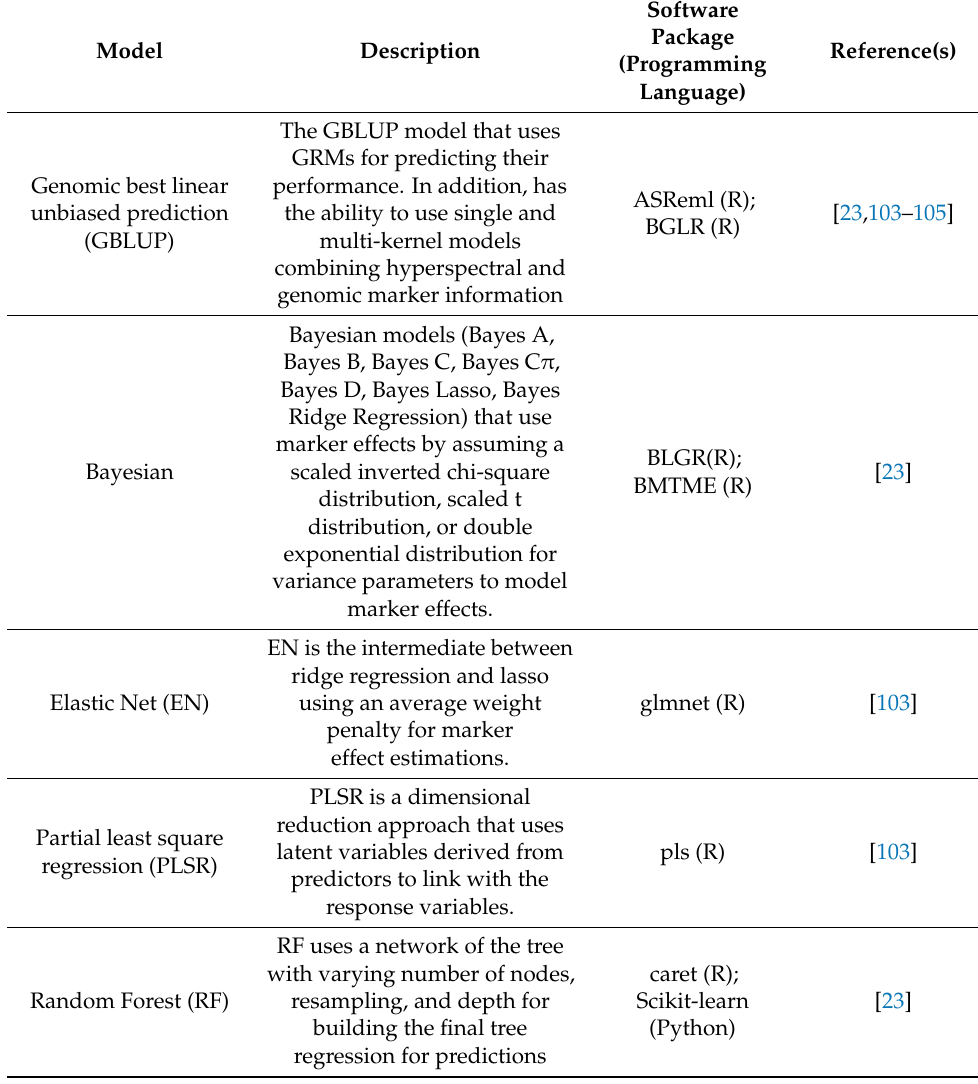
Table 2. Univariate and multivariate genomic selection (GS) models that have been used to incorpo- rate high-throughput phenotyping (HTP) spectral reflectance indices